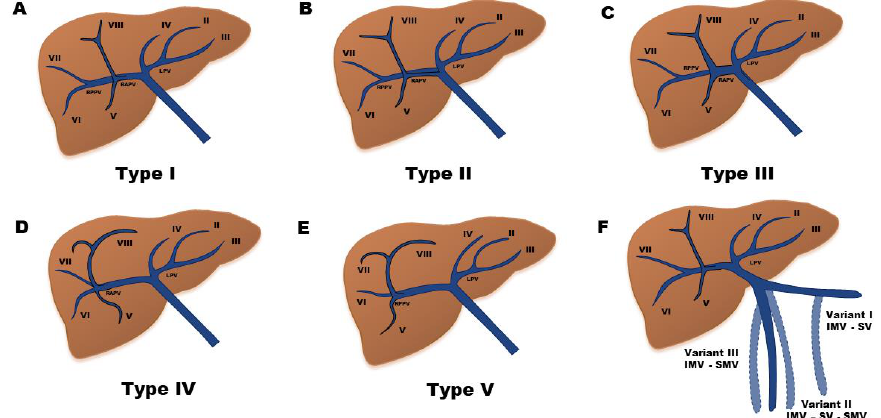
Figure 1. The intrahepatic portal vein has a segmental distribution and it closely follows the hepatic artery. Cheng Y [15] et al. classified intrahepatic portal vein variations into five different types. ( A ) Type 1 (65–80%): after its entry through the hilium, the main portal vein (MPV) divides into a larger right portal vein (RPV) and a smaller left portal vein (LPV). RPV is divided into an anterior branch (supplying segments V and VIII) and a posterior branch (supplying segments VI and VII). LVP runs horizontally to the left and then turns medially (supplying segments I, II, III, and IV). ( B ) Type II (10–15%): trifurcation of MVP, dividing into the right anterior and posterior branches and the LPV. ( C ) Type III (0.3–7%): the right posterior portal branch arises directly from the MPV as its first branch and the LPV is the terminal branch, arising after the origin of the right anterior portal vein. ( D ) Type IV (0.6–2.7%): trifurcation of the RPV, in which the branch of segment VII is the